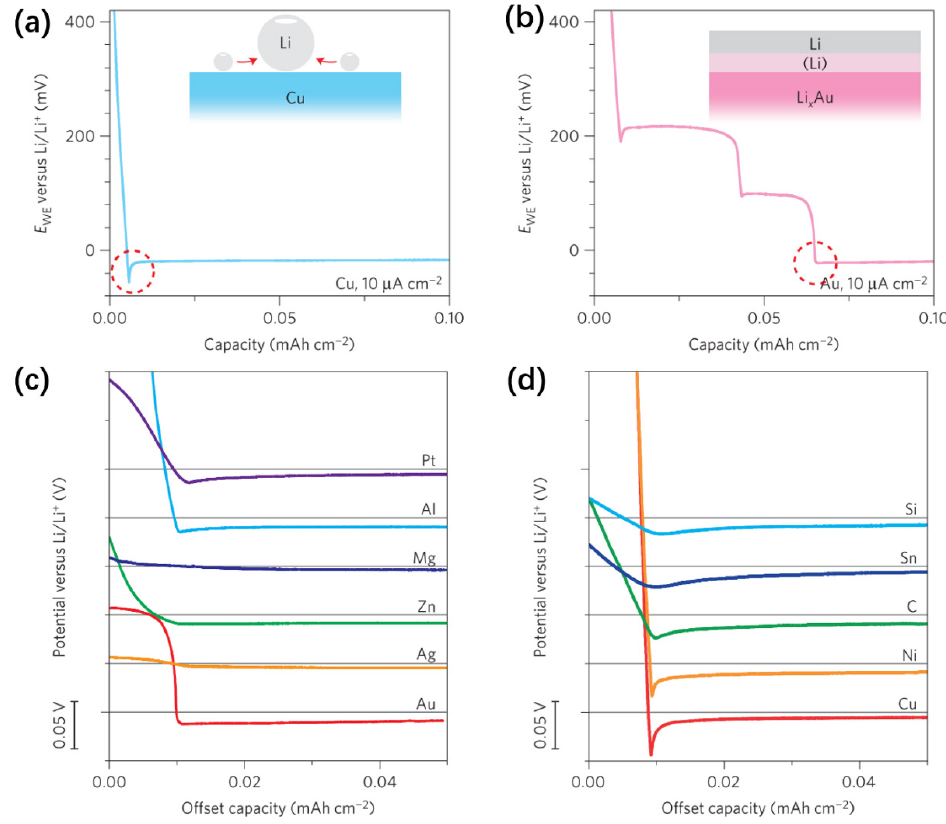
Figure 2. Voltage distributions of galvanostatic Li deposition on copper ( a ) and gold ( b ) substrates (EWE is the potential of the working electrode) ( c ) Voltage distributions of various materials with a certain solubility in Li during Li deposition, ( d ) Displacement voltage distributions for various materials with negligible solubility in Li [52].